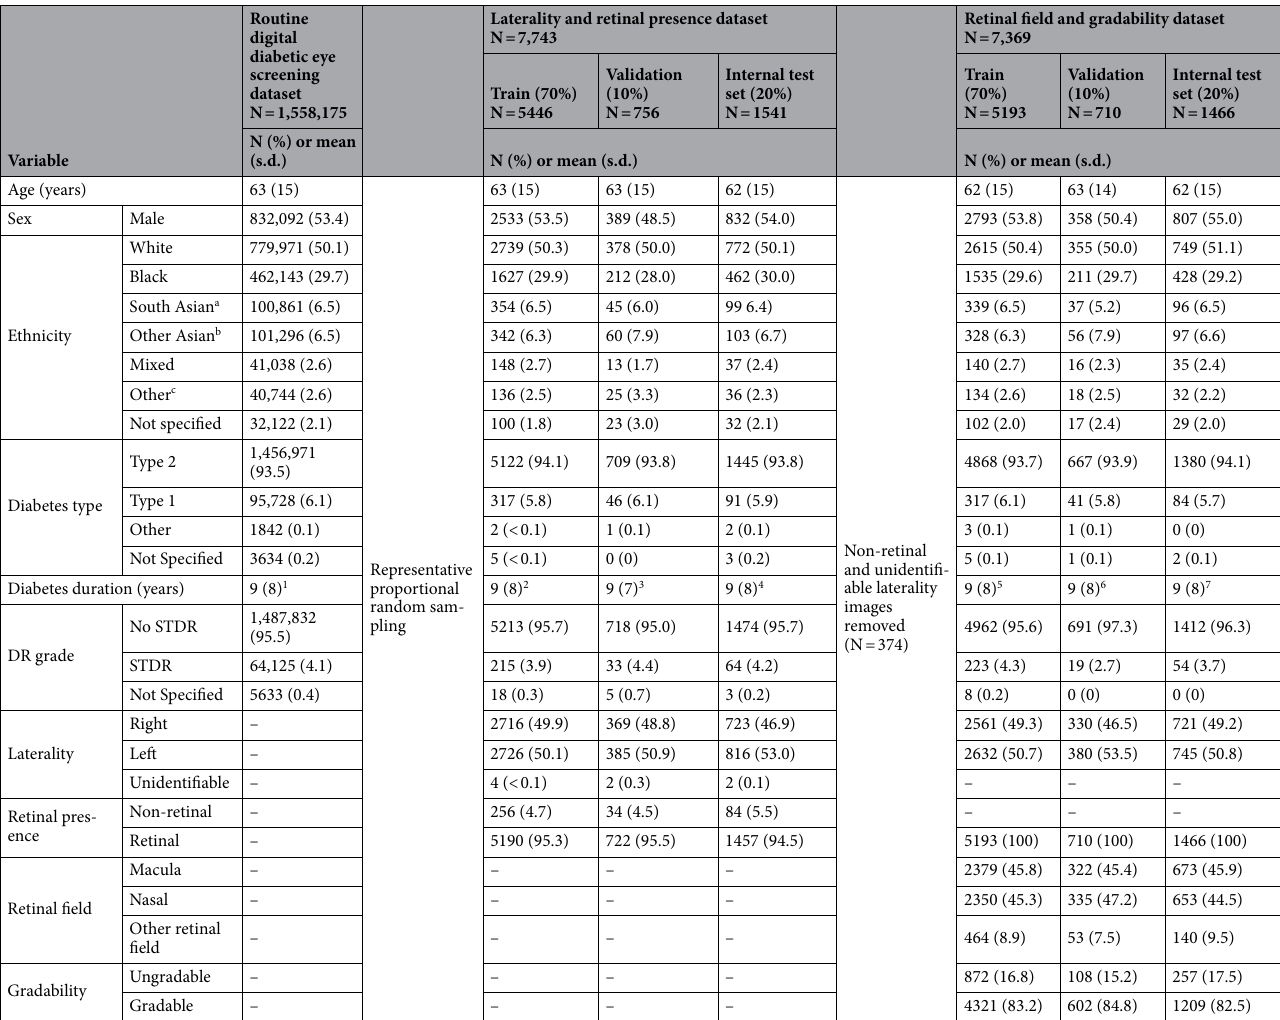
Table 1. South-east London routine diabetic eye screening dataset characteristics. a Includes Indian, Bangladeshi, and Pakistani ethnic backgrounds, b Includes any other asian background or Chinese, c Includes any other ethnic group or Arab, Missing values: 1 5,665, 2 13, 3 2, 4 6, 5 17, 6 2, 7 2, N: Images, s.d.